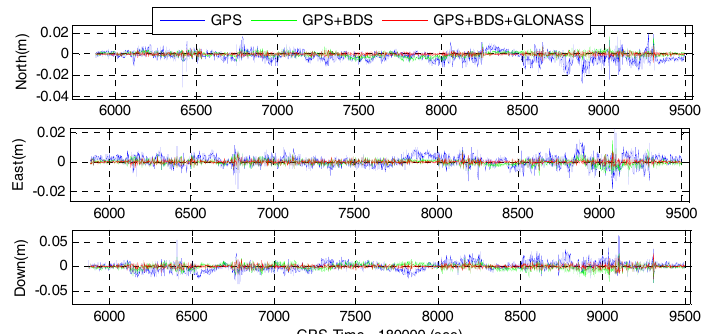
Figure 10. Position difference of RTK/INS for GPS, GPS/BDS, GPS/BDS/GLONASS at 15° cut-off elevation angle.